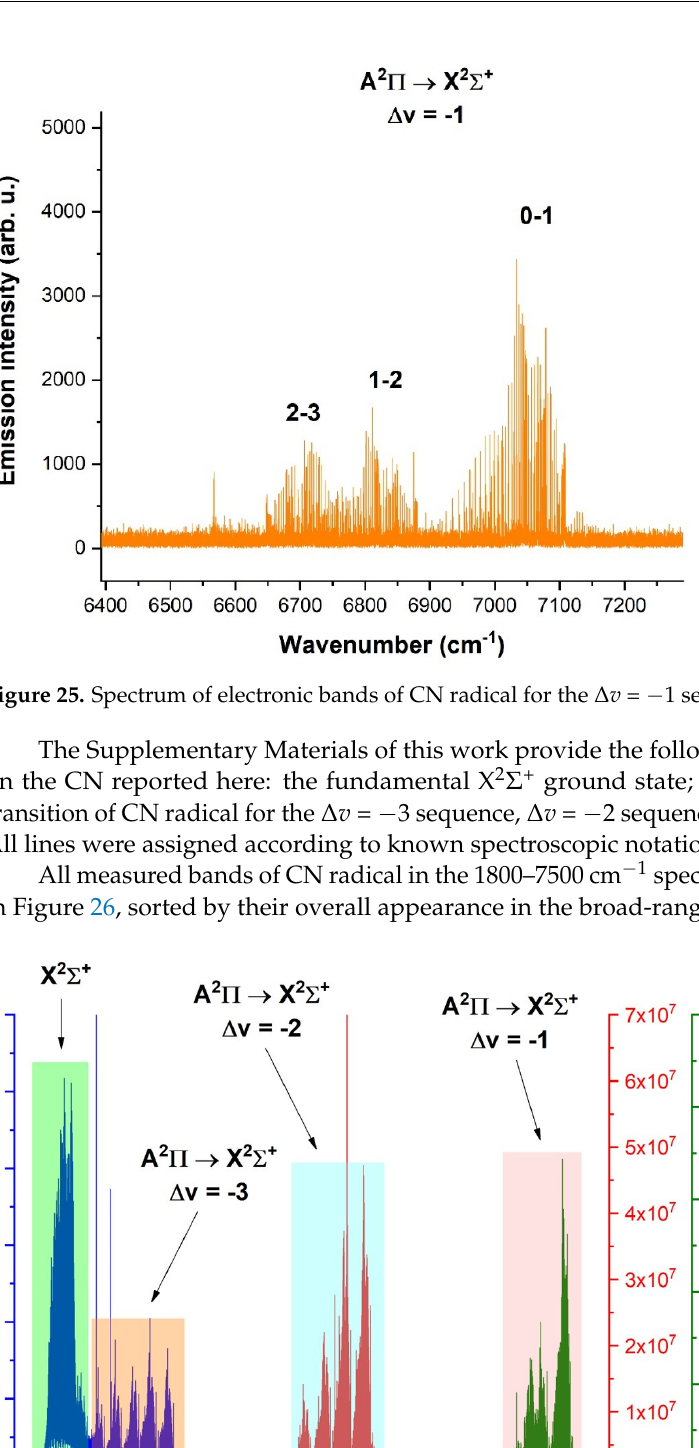
Figure 24. Spectrum of electronic bands of CN radical for the Δ v = − 2 sequence (36 µs).